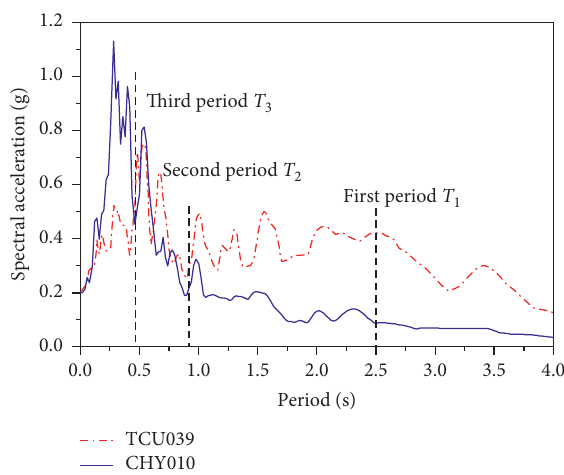
Figure 9: Spectra acceleration responses of TCU039 and CHY010 excitation.